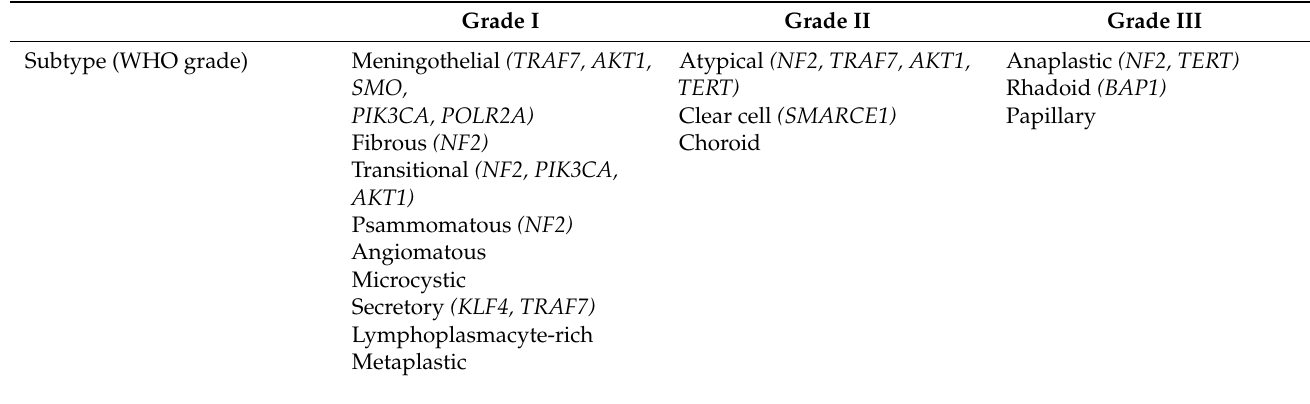
Table 2. Somatic and chromosomal mutations in relation to the WHO grade and subtype